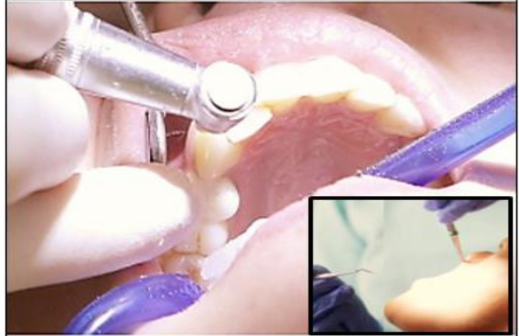
Figure 15. Ultraviolet light cure palm oil-based